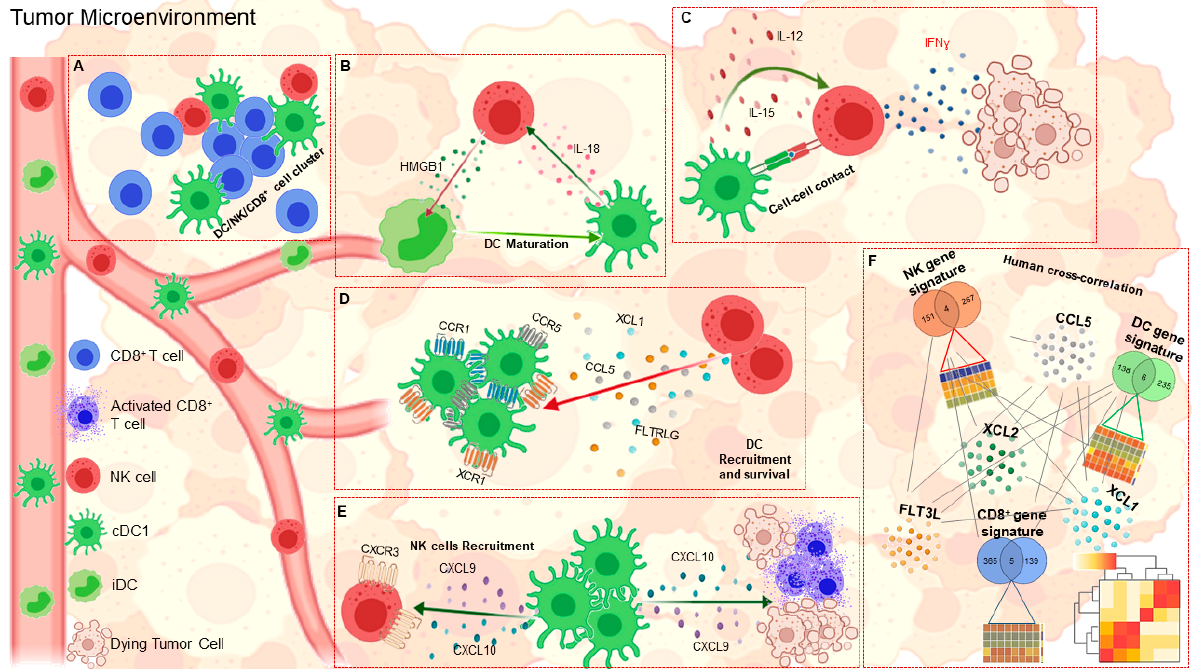
Figure 2. DCs-NK cells cross-talk in cancer immunity. ( A ), DCs, NK cells and CD8 + T cells interact with each other in the TME. ( B ), Loop of maturation of DCs by HMGB1 produced by NK cells and activation of NK cells by IL-18 released by DCs. ( C ), Ability of cDCs to increase IFN- γ production by NK cells and amplify their anti-tumor activity either by a cell-cell contact mechanism or by release of the cytokines IL-12 and IL-15. ( D ), Recruitment and survival of cDCs are dependent on the chemokines CCL5, XCL1/2 and FLT3L produced by NK cells. ( E ), CXCL9 and CXCL10 chemokines released by DCs are crucial for both recruitment and activation of NK cells and CD8 + T cells in the TME. ( F ), Significant correlations between the genetic signatures of cDC1s, NK cells and CD8 + T cells and the key molecules involved in the interaction between cDC1s and NK cells are essential for stratifying low- and high-risk cancer patients.